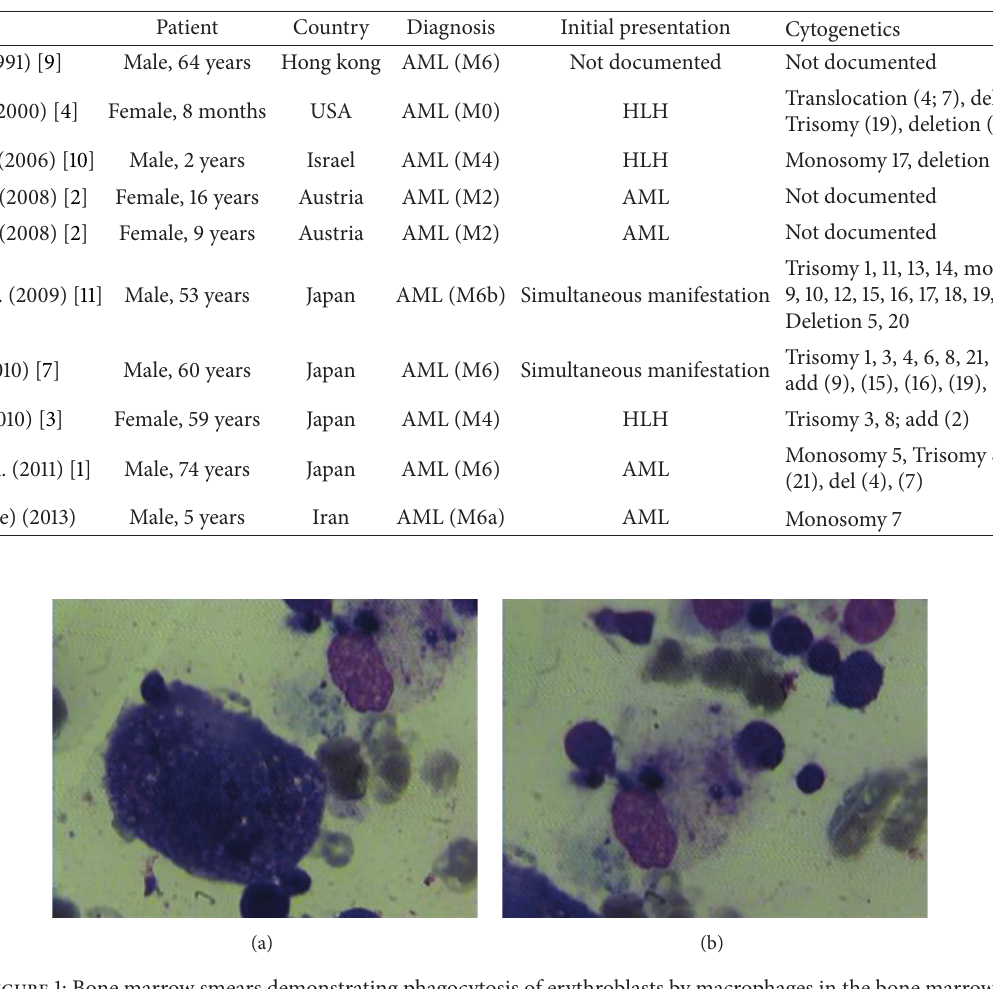
Figure 1: Bone marrow smears demonstrating phagocytosis of erythroblasts by macrophages in the bone